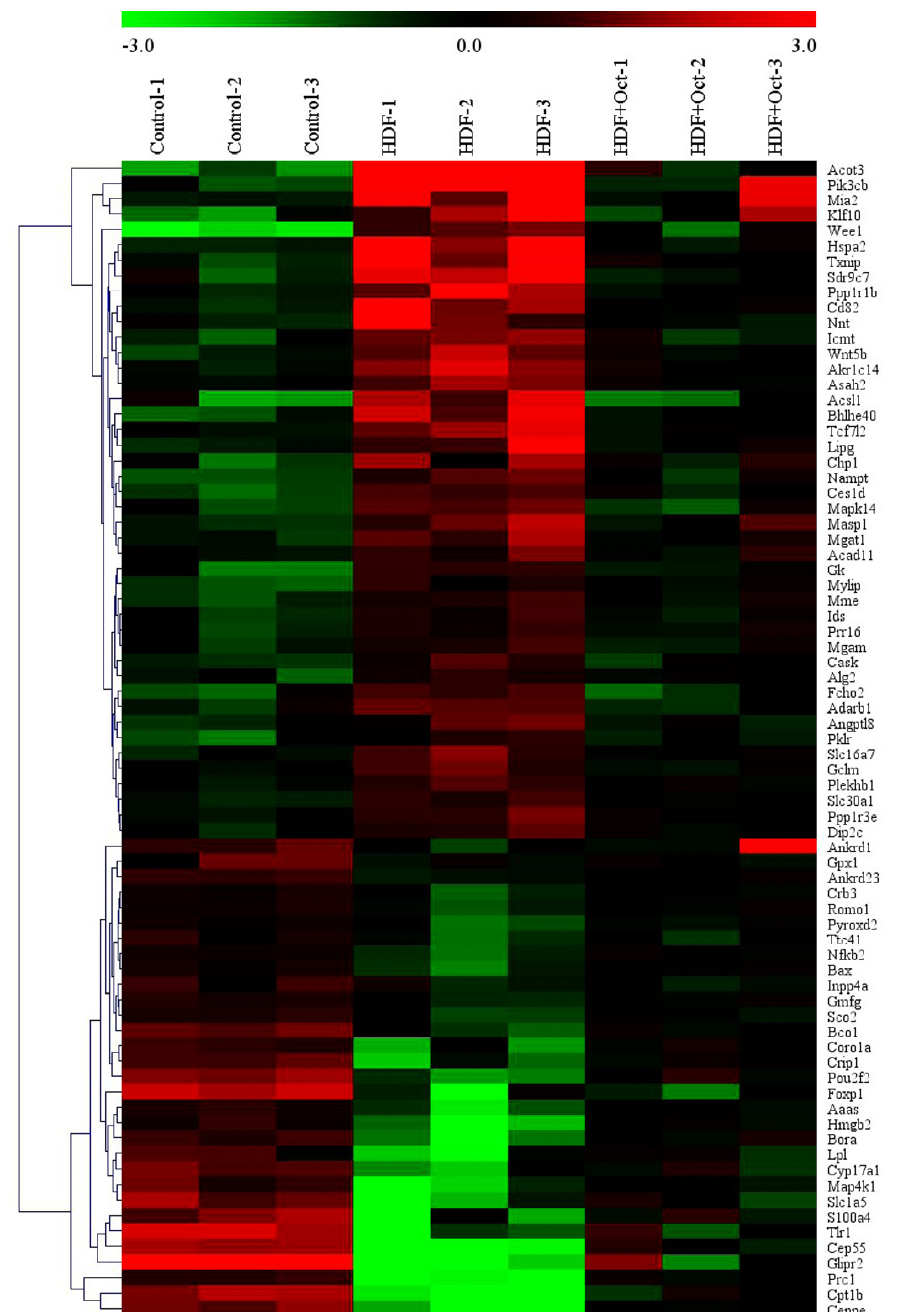
Figure 5. Clustering analysis showed the changed genes of HFD and HFD+Oct groups comparing with control group. Seventy-two differentially expressed genes were screened by gene chip analysis in both HFD and HFD+Oct groups. Color represents the log intensities. Red represents the increased expression genes; green represents the decreased expression genes. The dendrogram demonstrates clustering according to gene classification. The heatmap was plotted using MeV 4.4 software. Oct, octacosanol; HFD, high-fat diet.